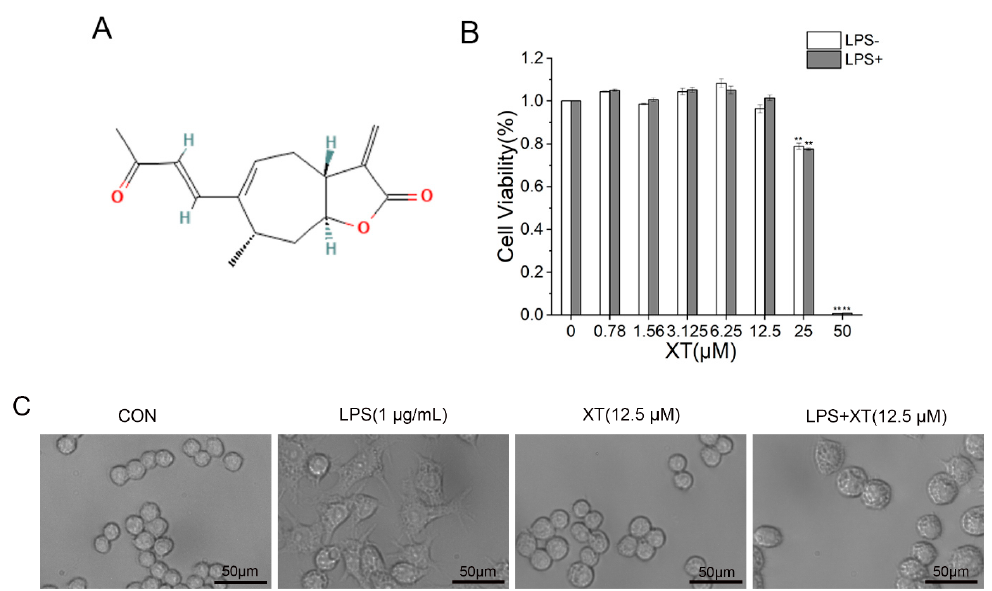
Figure 1. Cell viability of xanthatin. ( A ) The chemical structure of xanthatin. ( B ) Cytotoxicity of xanthatin at various concentrations (0 − 50 μ M) in the presence of LPS on RAW 264.7 cells, followed by the CCK − 8 kits. ( C ) Microscopy images of cellular morphology. Scale bar = 50 μ m. Data is shown as means ± SDs (n = 3). #: significantly different compared to the control (CON) group, **: p < 0.01 as compared to the LPS − induced group.